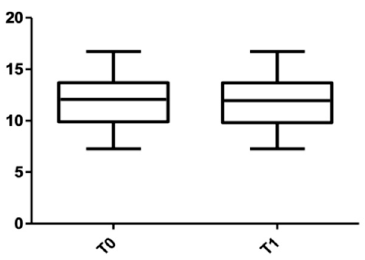
Figure 12. Root length distribution in the lower arch at T0 and T1. Table 7. Root length at T0 and T1 for maxillary teeth.